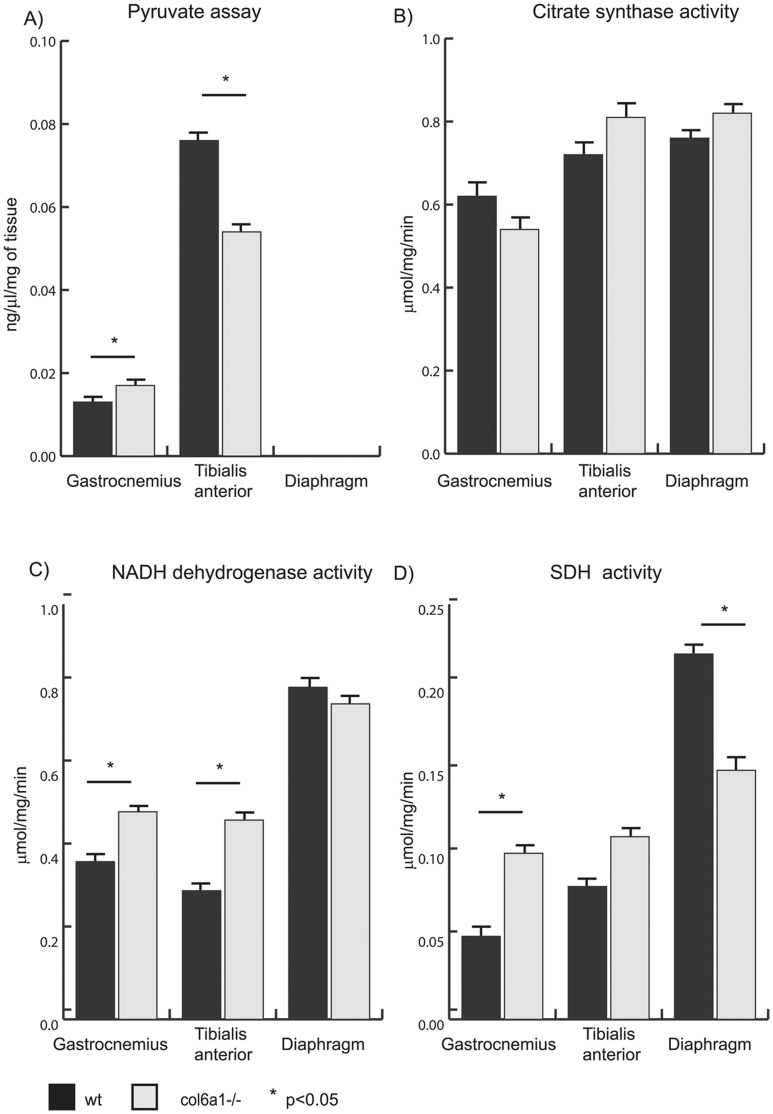
Results of enzymatic assays.Histograms showing pyruvate quantitation (panel A), citrate synthase enzymatic activity (panel B), NADH dehydrogenase (complex I) enzymatic activity (panel C) and succinate dehydrogenase (SDH, complex II) enzymatic activity (panel D) in gastrocnemius, tibialis anterior and diaphragm muscles from Col6a1
−/− and wild-type (wt) mice.